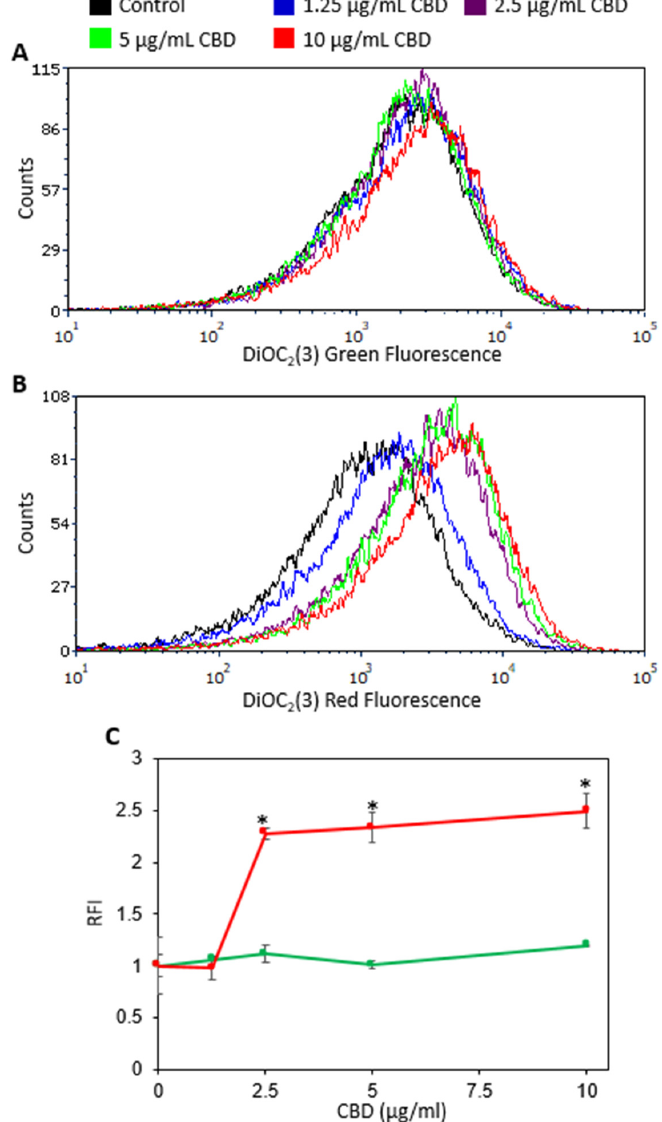
Figure 7. The membrane potential was measured using the DiOC 2 (3) potentiometric dye on flow cytometry immediately after adding CBD. ( A ) The green fluorescence intensity is an indication of the amount of dye taken up by the bacteria. ( B ) Red fluorescence intensity is an indication for the strength of the membrane potential. ( C ) Summaries of the relative fluorescence intensity (RFI) of the red (red lines) and green (green lines) fluorescence for the immediate CBD effect. An increase in the red/green fluorescence ratio is an indication for membrane hyperpolarization. The average ± SEM of a representative experiment performed in triplicates is presented. * p < 0.05 in comparison to the control.